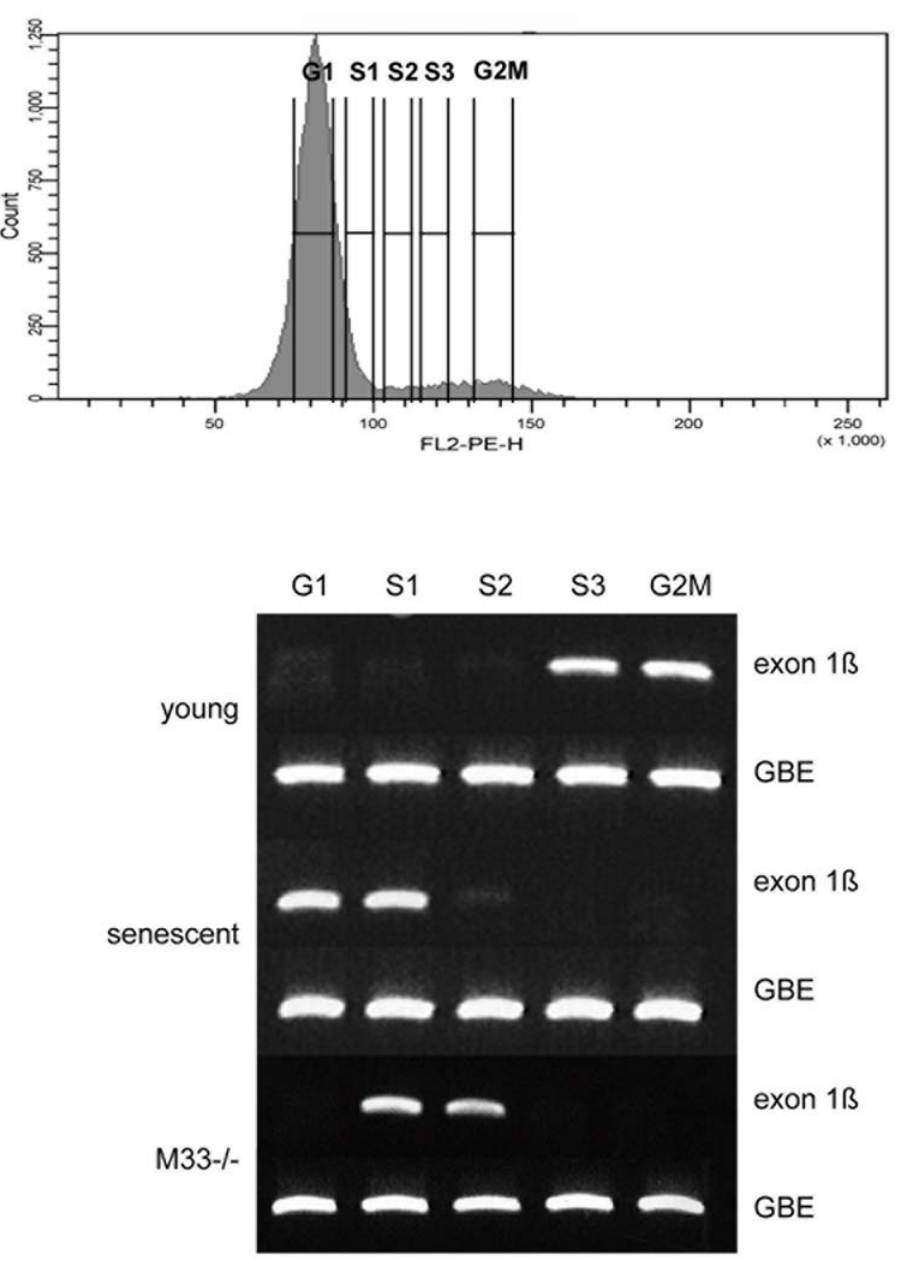
Figure 5. INK4a/ARF timing of replication. PCR based analysis of replication timing of the INK4a/ARF locus (exon 1b). BrdU pulse labeled cells were stained for DNA content with propidium iodide and sorted by flow cytometry into 5 cell cycle fractions (G1, S1, S2, S3 and G2M) according to DNA content. The Gbe D. melanogaster gene provides a control for recovery of BrdU-labeled DNA.